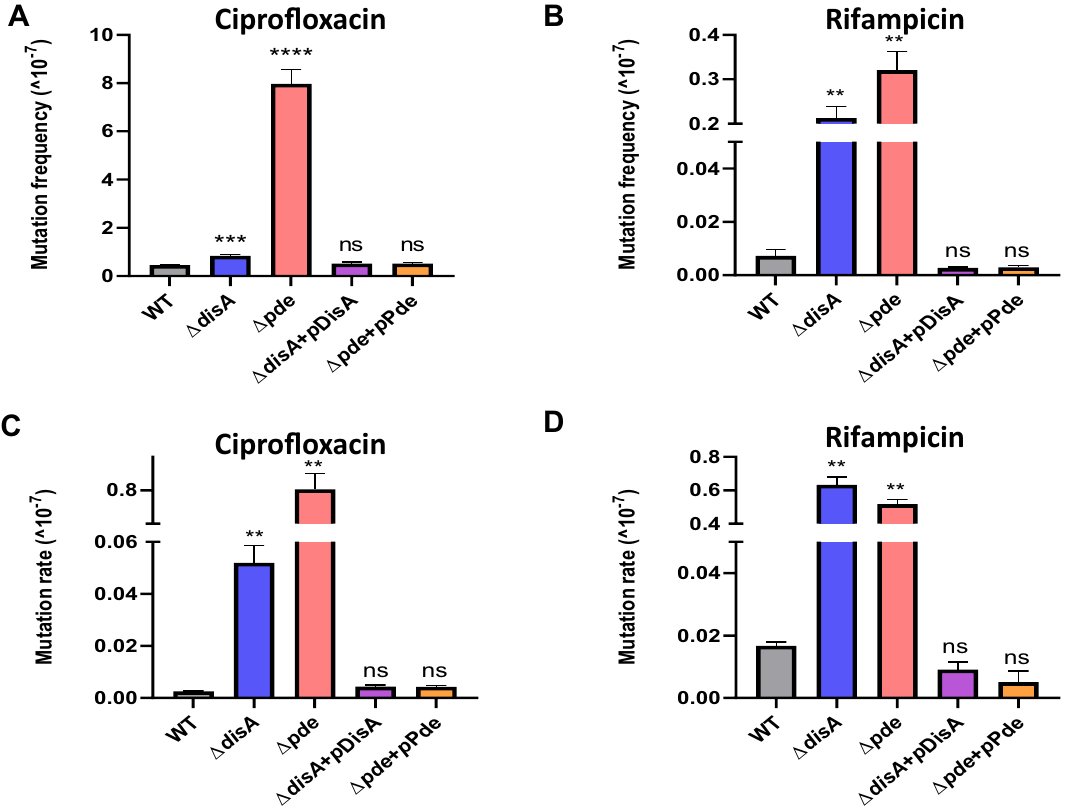
Figure 1. Modulating intracellular c-di-AMP concentration affects the number of spontaneous resistant mutants against ciprofloxacin and rifampicin. ( A ) ciprofloxacin mutation frequency and ( B ) rifampicin mutation frequency were calculated for M. smegmatis WT, M. smegmatis ΔdisA , M. smegmatis Δpde and their respective complementation strains [N = 3]. All the strains were grown till stationary phase. Similarly, ( C ) ciprofloxacin mutation rate and ( D ) rifampicin mutation rate were calculated for M. smegmatis WT, M. smegmatis ΔdisA , M. smegmatis Δpde along with respective complementation strains [N = 3]. All the graphs are plotted using GraphPad Prism8, unpaired t-test was used to calculate statistical significance: ***P < 0.001; **P < 0.01; *P < 0.05; ns = non-